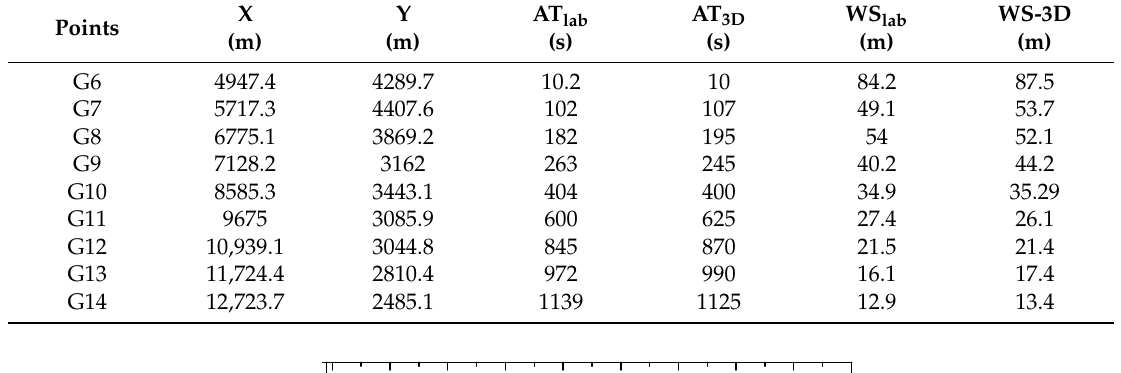
Table 4. Arrival time (AT) and water surface (WS) results from the in-scale model (AT lab , WS lab ) [8,46] and from the present 3D computational results (AT 3D , WS-3D). The errors between laboratory data and 3D model results are AT err , WS err .